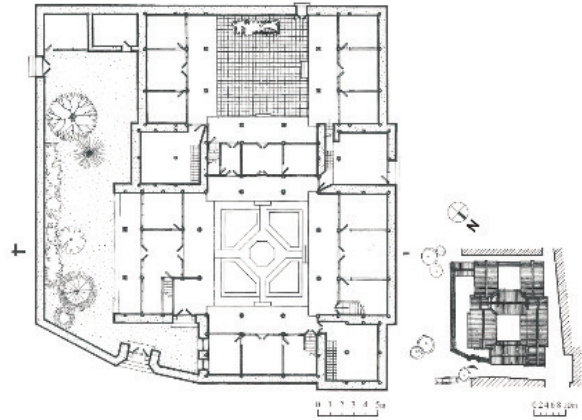
Figure 16. Floo r plan of ground level of Case B (left ); site plan of Case B. Th e Zhaos House, 489, Renmin Street built circa 1920 (right) (source: Zhu, 2020; personal communication, 18